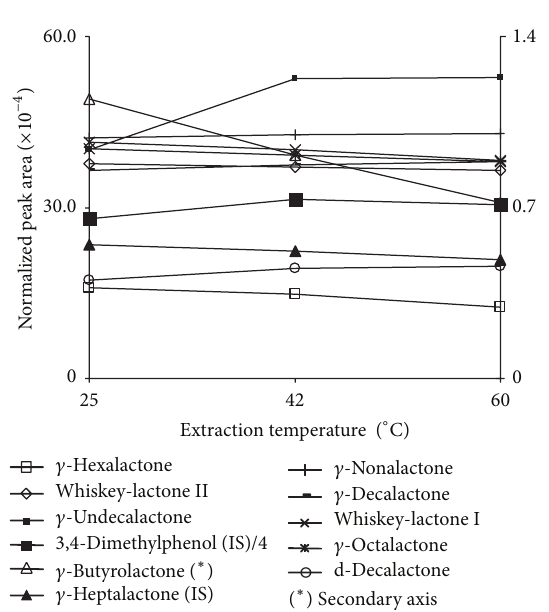
Figure 4: Influence of ionic strength on the extraction of the different analytes on a PA fiber.